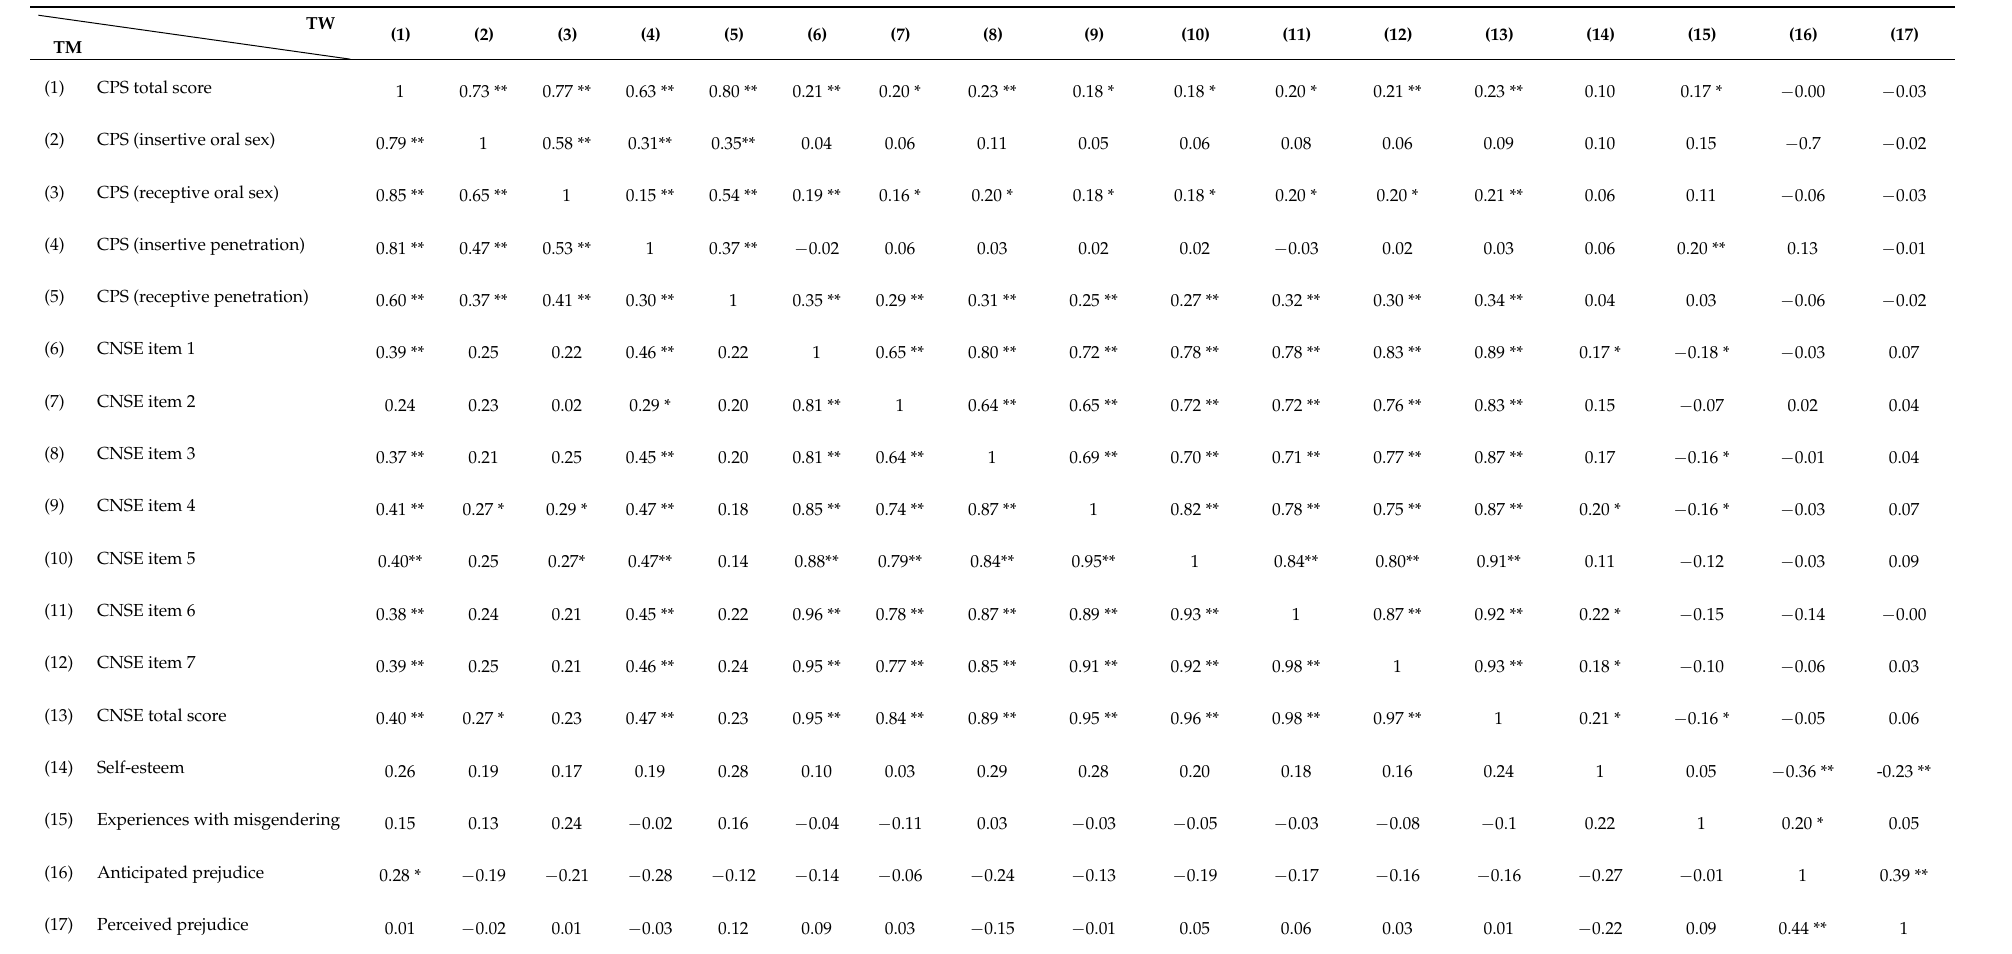
Table 3. Pearson correlation matrix ( n = 122 to